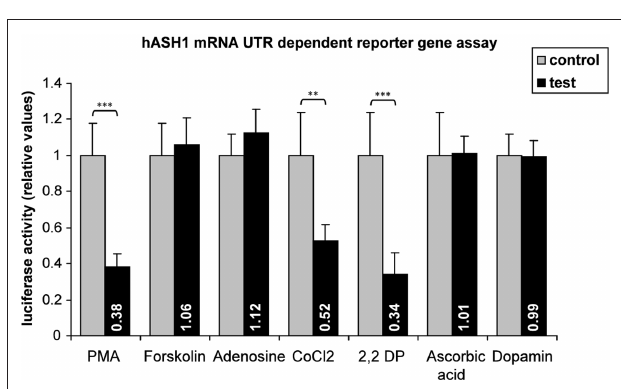
Figure 4 | Screening for conditions leading to an alteration in gene expression rate mediated by hASH1 mrNA 5 ′ - and 3 ′ uTrs. Kelly cells were transiently transfected (36 h) with reporter constructs where the luciferase mRNA UTRs were replaced by the hASH1 mRNA UTRs. Transcription rate was controlled by the constitutive SV40 promoter. Cells were treated with different compounds for 24 h. The concentrations used were: PMA = 40 nM; Forskolin = 100 nM; adenosine = 100 nM; cobaltous chloride